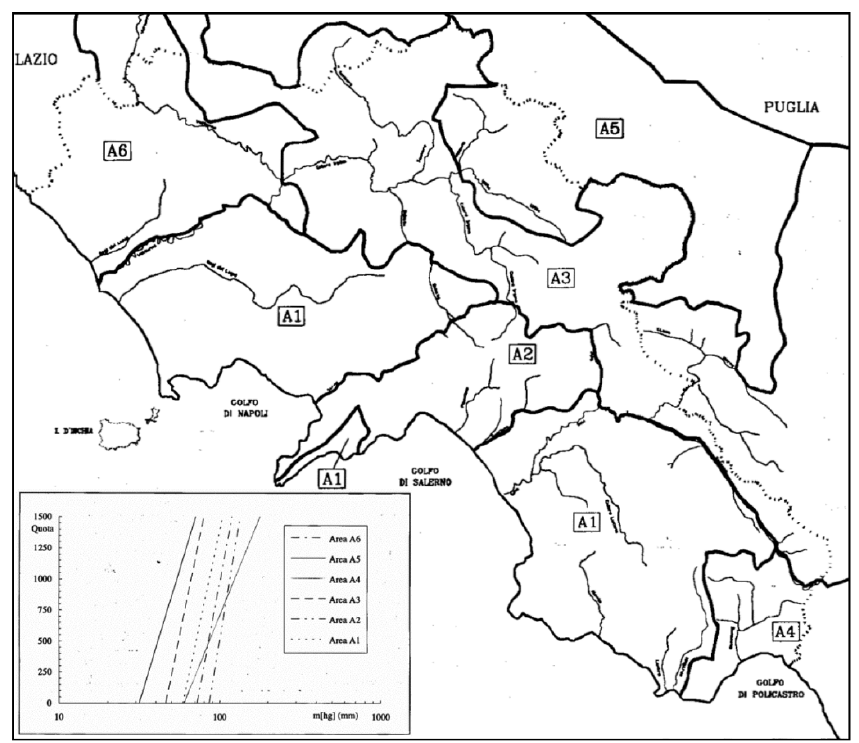
Figure 4. Map of the six homogeneous sub-regions for the mean annual daily rainfall maxima and linear relationships with elevation from VAPI Campania report. Reproduced with permission from Rossi, F . et al. Valutazione Delle Piene in Campania ; Published by CNR-GNDCI, 1995